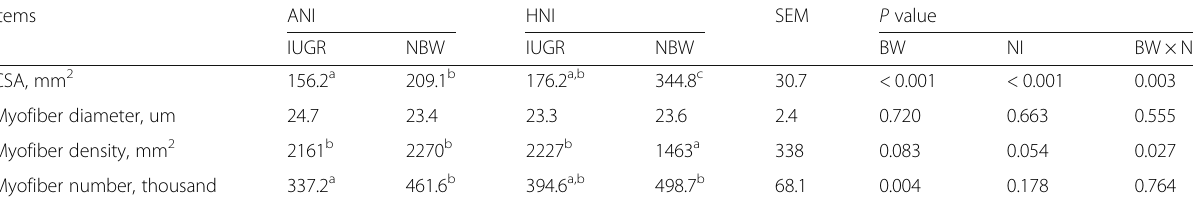
Table 4 Effects of the level of nutrient intake on histomorphometry of psoas major muscle of intrauterine growth-restricted (IUGR) and normal birth weight (NBW) pigs Items ANI HNI